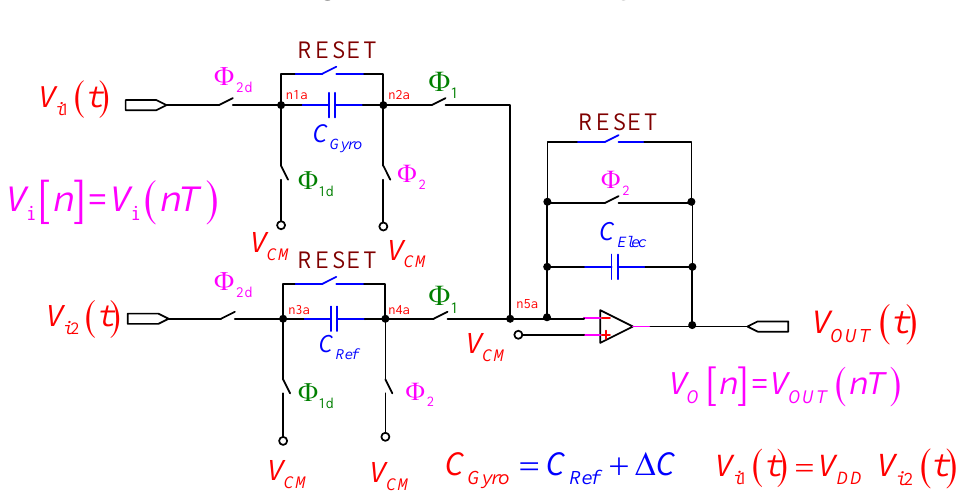
Figure 1. The PISC sensing circuit.